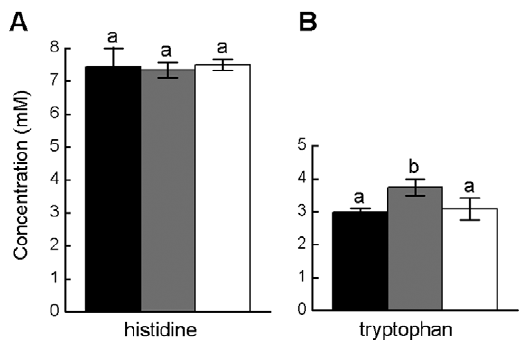
Figure 3. Quantification of amino acid concentrations in the culture supernatant of two mutant E.coli strains. Mean ( 6 95% confidence interval)amount of (A)histidine producedby E. coli D hisL , and (B) tryptophan produced by E. coli D trpcC as determined by conventional HPLC measurements (black bar) or the growth of the respective biosensors, which was quantified turbidometrically (OD 600 nm , grey bar) or GFP fluorescence emission (white bar). Different letters indicate significant differences (S-N-K test: P , 0.05, n=4).